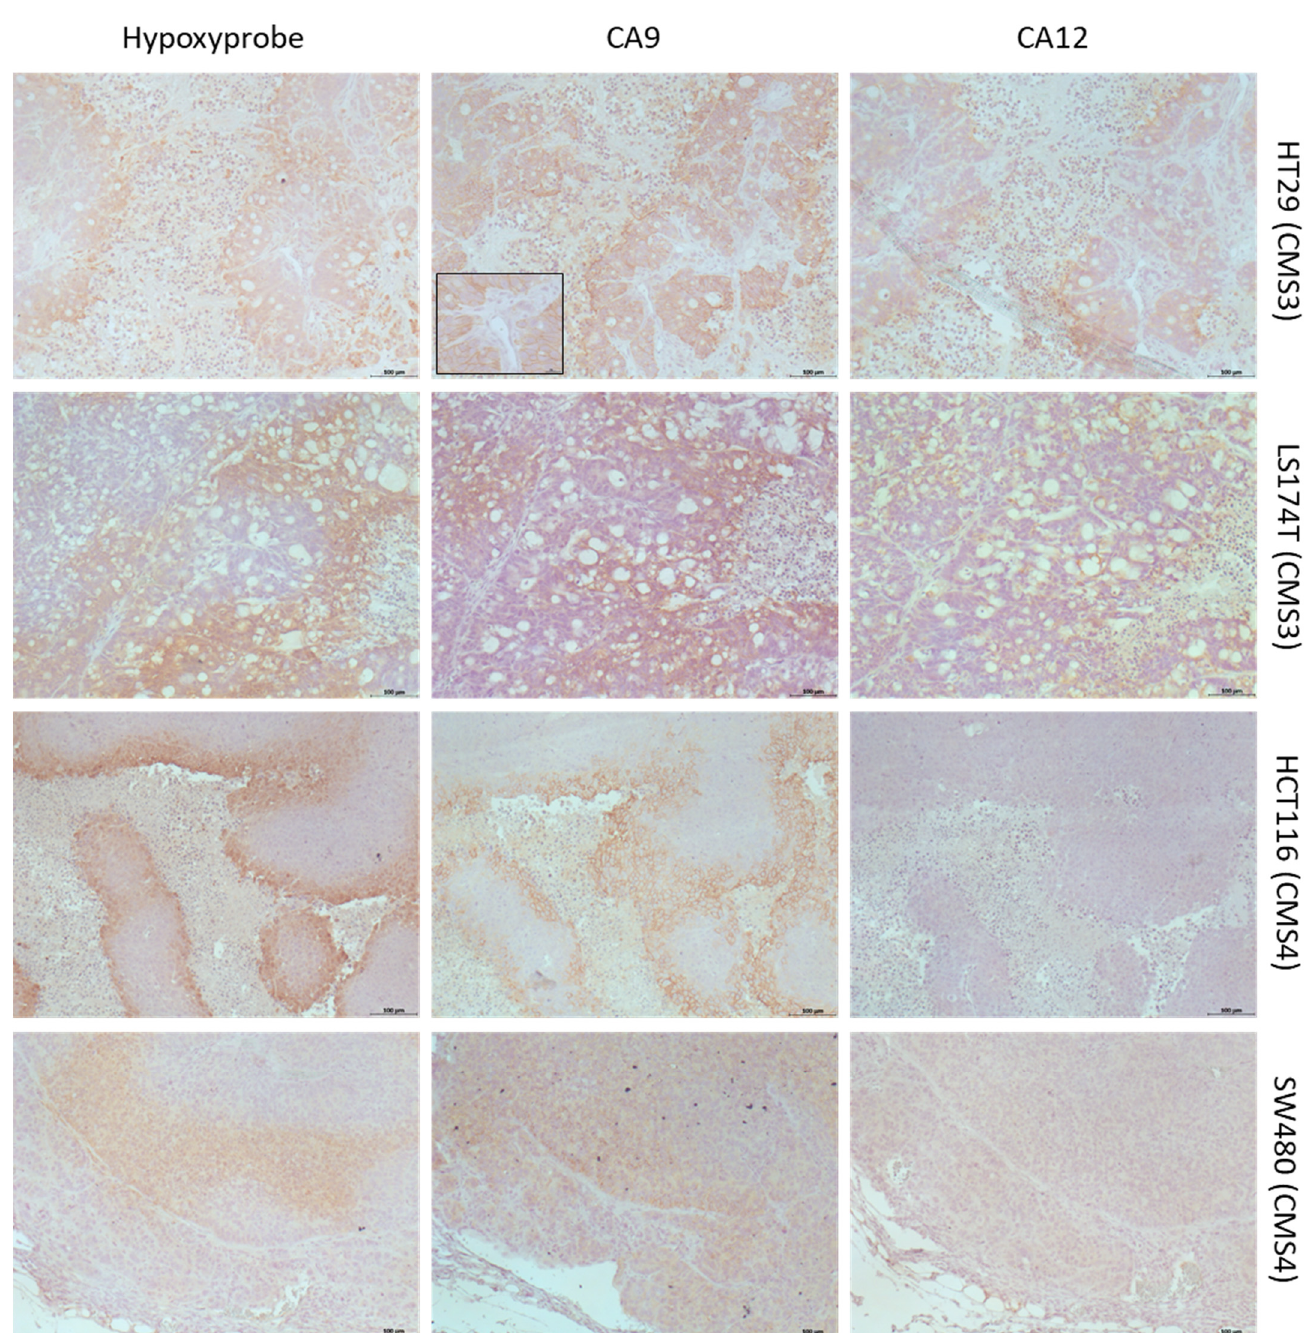
Figure 2. Immunohistochemical analyses of expression of CAIX and CAXII and presence of hypoxia (Hypoxyprobe, pimonidazole) in xenograft tumors representing different CMS. Staining was per- formed on direct following slides to capture the same tumor areas for analyses. Original pictures with higher quality, including selected images with higher magnification, can be found in Figure S2 (Supplementary Materials). LOVO (CMS1): CAIX expression is rare; positive cells are associated with hypoxic perinecrotic areas (arrow). CAXII is more frequently found and can occur outside of hypoxic tissue, even adjacent to vessels (arrows). SW48 (CMS1): CAIX is rare or absent despite hy- poxia. CAXII is not found. SW1463 (CMS2): CAIX is nearly ubiquitously expressed and is found bound to hypoxic areas (arrow below) as well as independent of hypoxia (upper arrow). CAXII- positive cells can be found, but the signal is confined to the cytoplasmic compartment of colonic epithelial-like cells building ducts (inserted picture). LS1034 (CMS2): CAIX expression is frequent but rarer compared to SW1463 and more associated to hypoxia in comparison to SW1463 tumors. CAXII expression shows the same phenomenon as described for SW1463 (not shown). HT29